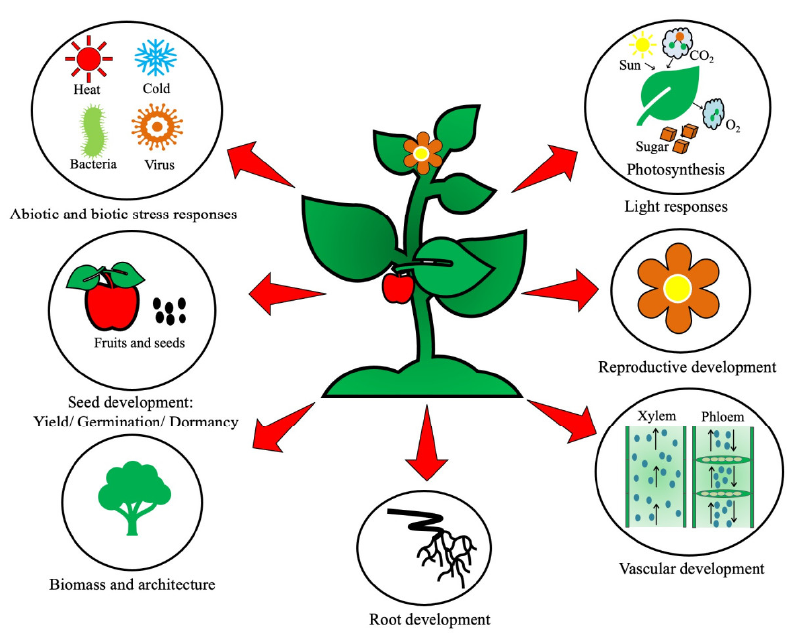
Figure 1. Active regulation of a wide array of developmental processes in plants by Brassinosteroids (BRs).